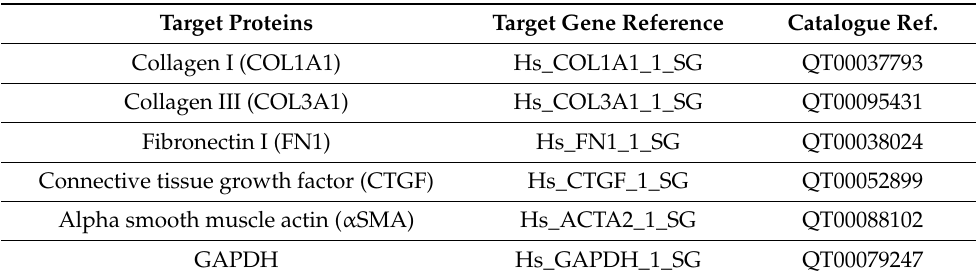
Table 1. List of gene transcripts analysed by qRT-PCR; Qiagen Quantitect-validated primers were used to analyse gene expression levels of target proteins.